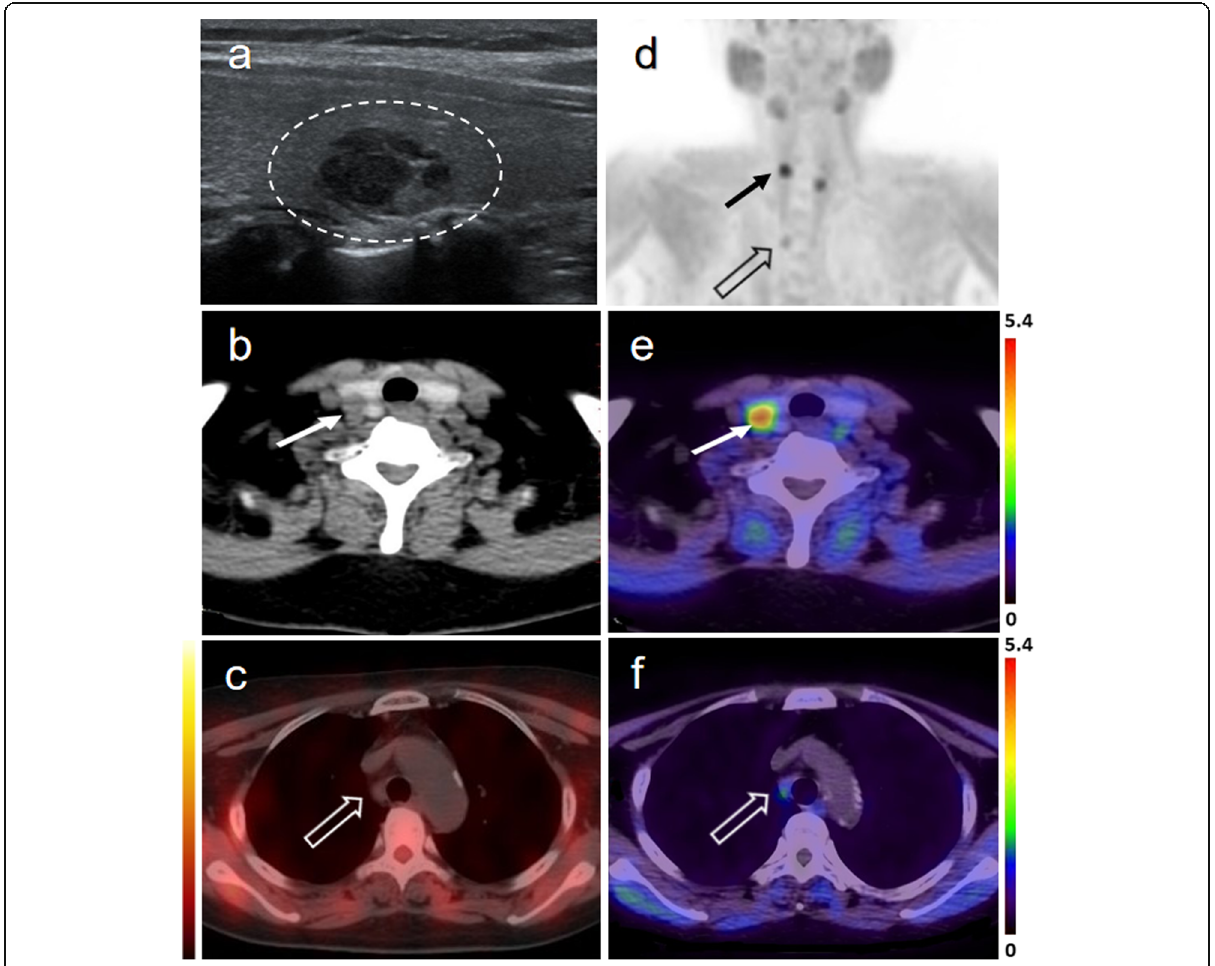
Fig. 2 Images from a 61-year-old woman with multiple parathyroid hyperplasia, one with a slightly ectopic (in the middle portion of the right thyroid gland) localization. US misdiagnosed this lesion as a thyroid nodule (dotted circle) ( a ). The lesion is well delineated on the MIP image of 18 F-FCH PET ( d ), axial CT ( b ), and PET/CT fusion images ( e ) (arrows). A heterogeneous low-density nodule in the upper mediastinum is well- delineated on the MIP image of 18 F-FCH PET ( d ) and PET/CT fusion images ( f ) (hollow arrows), but no abnormal tracer uptake was observed on a 99m Tc-sestaMIBI SPECT/CT image ( c ) (hollow